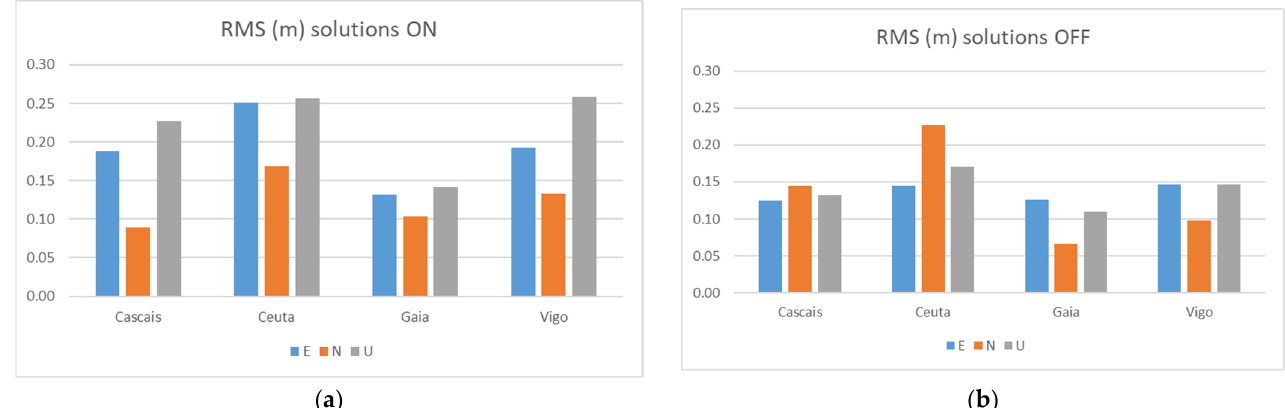
Figure 11. RMS Galileo + GPS solutions from the two smartphones at Test 1: flight mode on ( a ) and flight mode off ( b ).